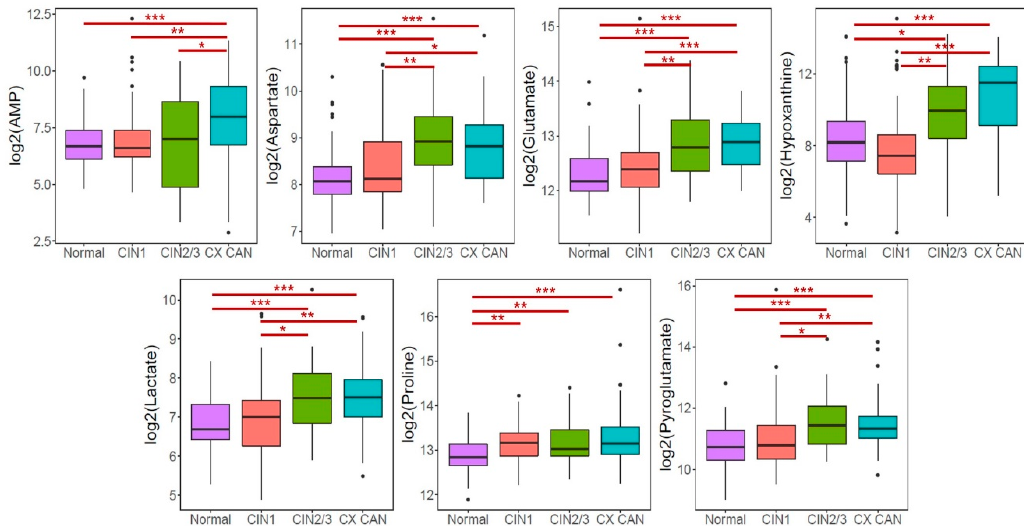
Figure 3. Boxplots of metabolites between normal and cervical cancer. Post-hoc multiple comparisons using Bonfferoni method was performed for significant difference. * p < 0.05, ** p < 0.01, *** p < 0.001. CIN1: Cervical intraepithelial neoplasia 1, CIN2/3: Cervical intraepithelial neoplasia 2 or 3, CX CAN: Cervical cancer.